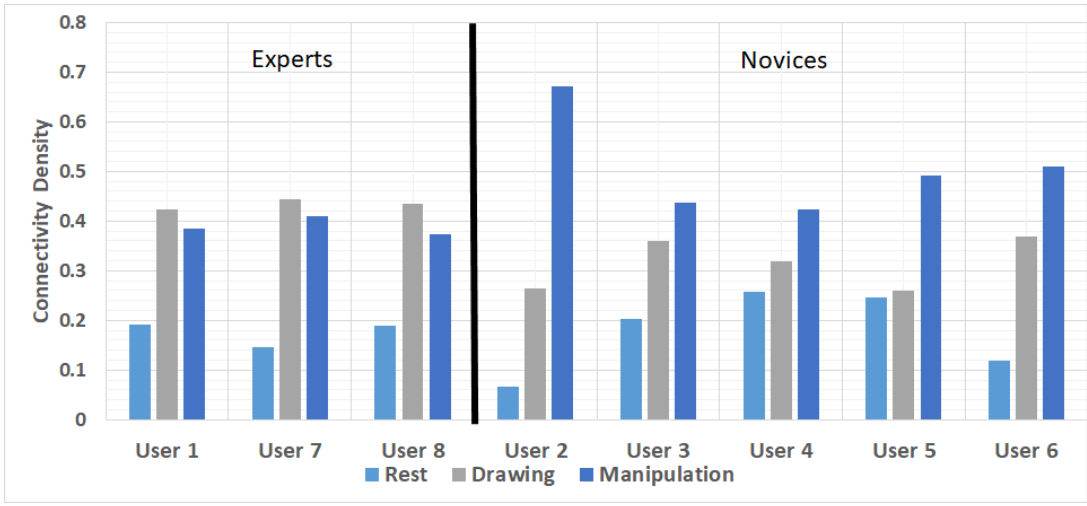
Figure 10. Comparison of connectivity density of all users brain activity during rest, drawing and manipulation